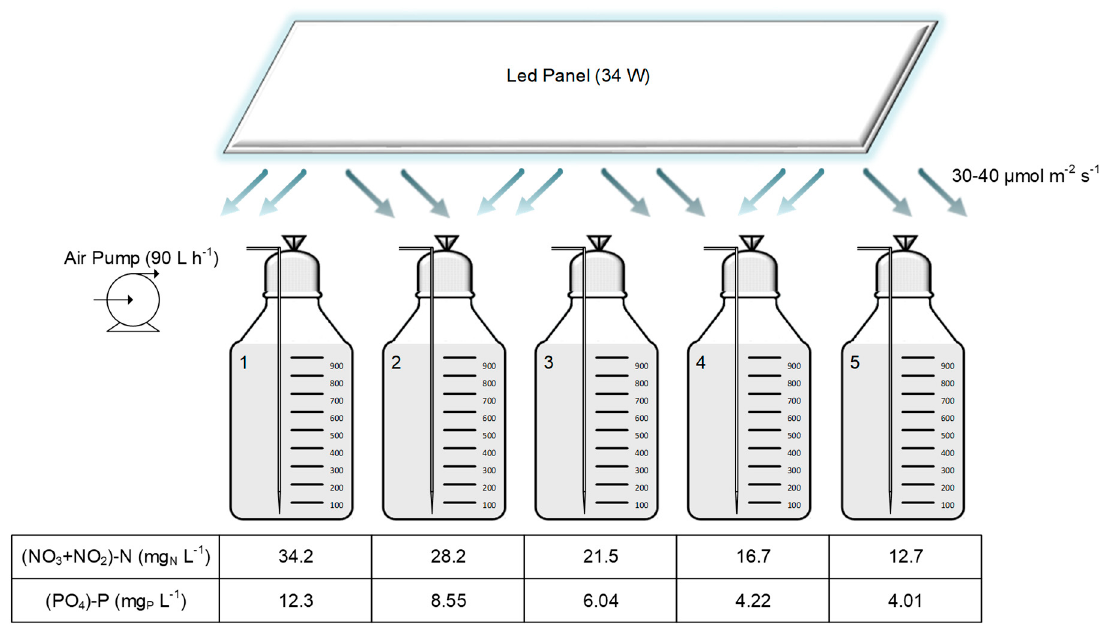
Figure 1. Schematic representation of the experimental setup.